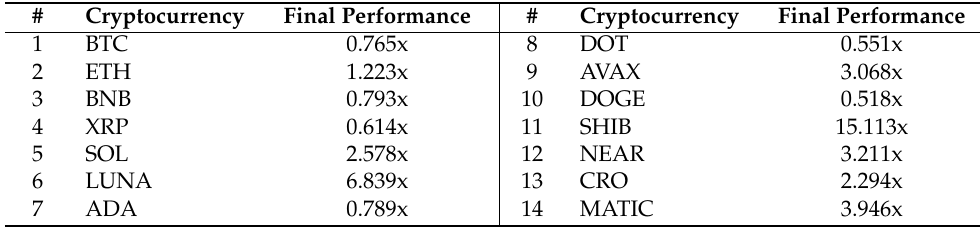
Table 8. Performance indicator of the portfolio positions, at the end of the investment period, based on the initial investment.